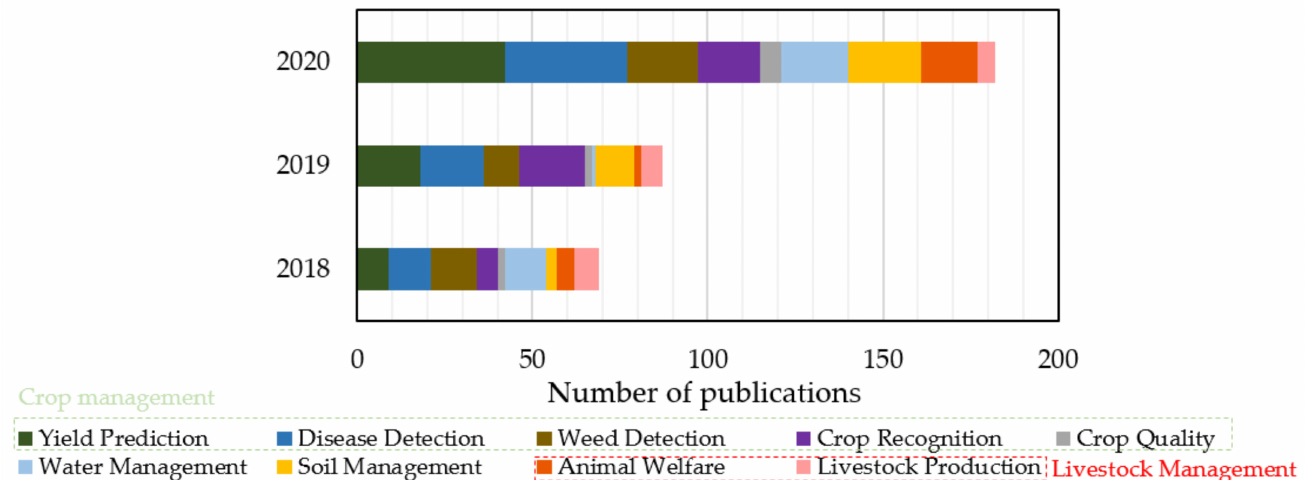
Figure 13. Temporal distribution of the reviewed studies focusing on machine learning in agriculture, which were published within